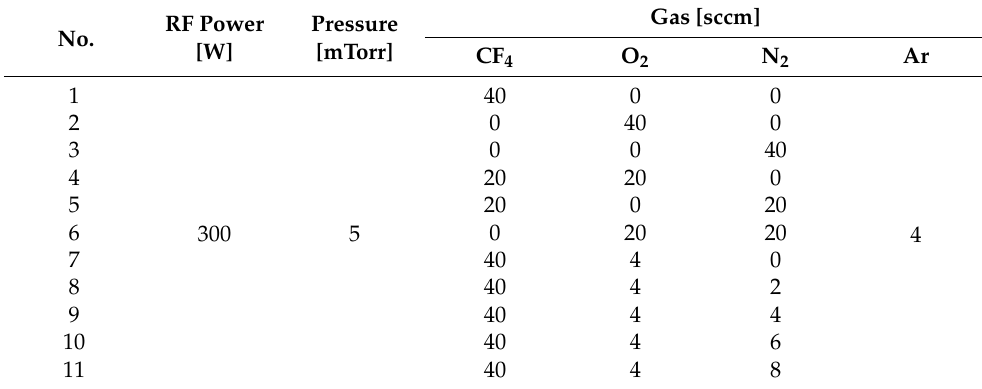
Table 1. Process recipe of all single and mixed gas plasmas.